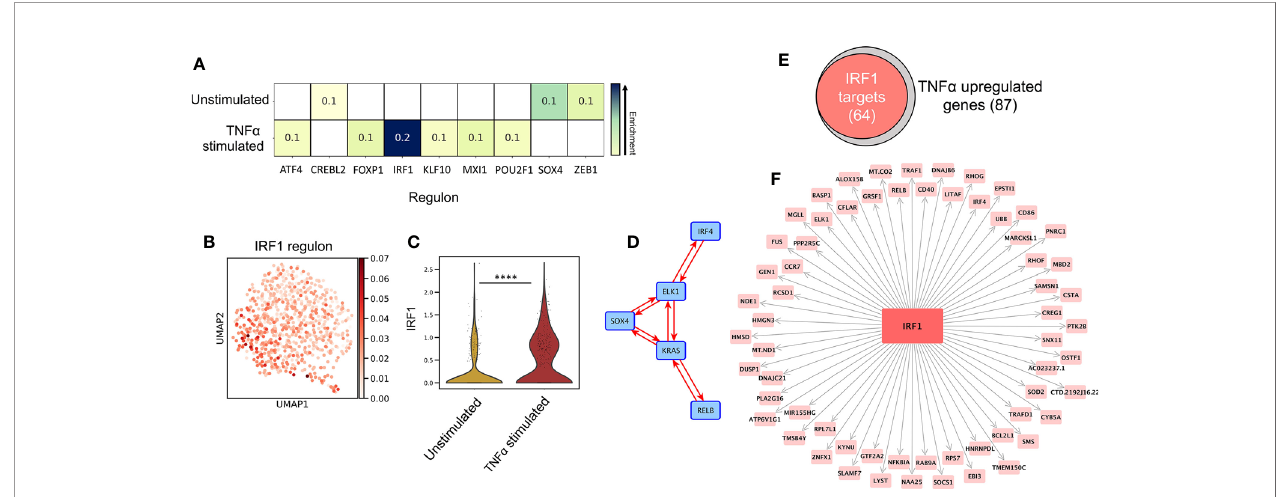
FIGURE 2 | IRF1 expression controls immunogenic transcriptional programming. (A) SCENIC regulatory network and inference clustering analysis revealed TF regulons which were enriched in unstimulated and TNF-alpha stimulated LCs. Z-score heatmap (yellow -> blue) of enriched regulons are displayed (z-score>0.1). (B) UMAP marker plot displaying IRF1 regulon enrichment (z-score) in individual LCs. (C) Violin plot displaying the level of transcriptomic expression of IRF1 in unstimulated and TNF-alpha stimulated LCs, MAST, ****p<0.001. (D) PIDC network graph displaying connectivity (edge weight >1.5) between a regulatory module comprising of SOX4, KRAS, IRF4, RELB and ELK1 in unstimulated LCs. (E) Venn Diagram displaying the overlap in TNF-alpha stimulated LC upregulated genes identi fi ed to be targets of IRF1 in PIDC analysis (edge weight >1). (F) PIDC network graph displaying IRF1 targets (edge weight >1) identi fi ed within TNF-alpha stimulated LC upregulated